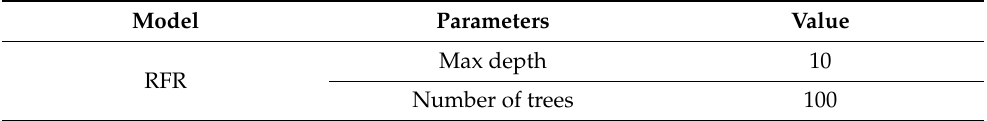
Table 2. Hyperparameters of RF model.